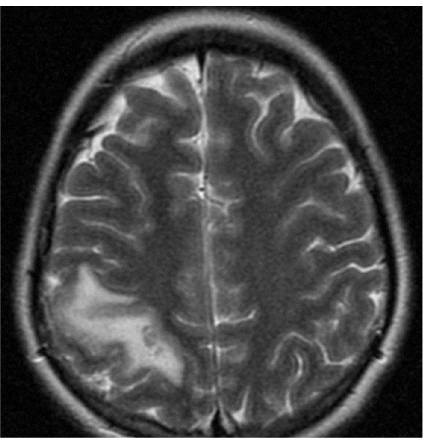
Figure 4. Magnetic resonance (MR) T2-weighted imaging in the axial plane shows cerebral infarc- tion in the right parietal cortex crossing anatomic arterial distributions with hemorrhagic transfor- mation.